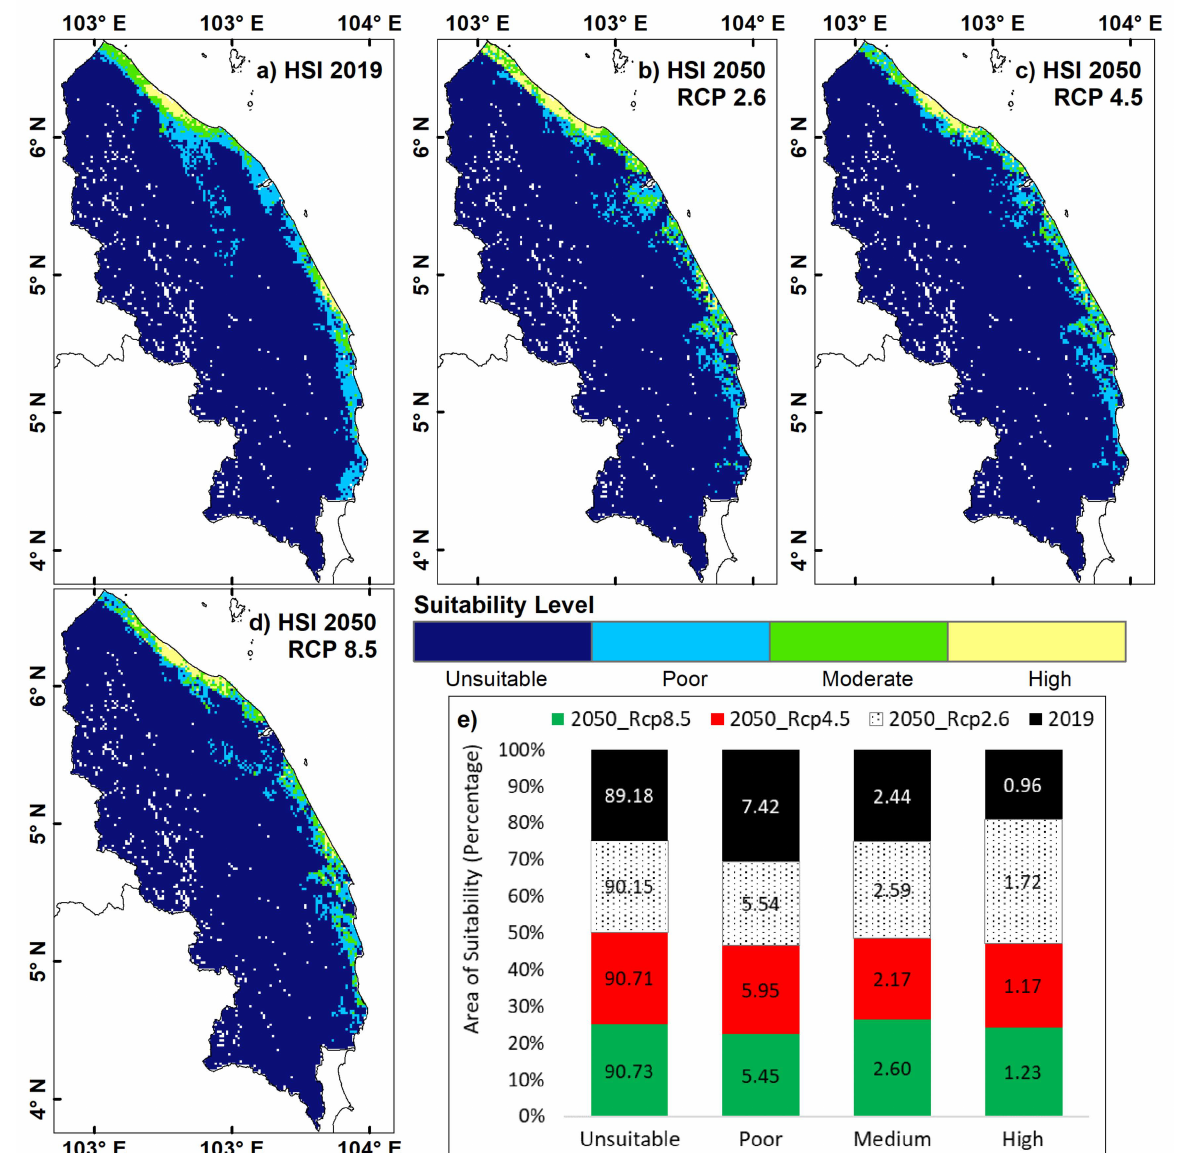
Figure 6. Prediction of potentially suitable habitat for M. cajuputi species in Terengganu, Malaysia. The suitability index was classified into high (0.75–1.0), medium (0.5–0.75), poor (0.25–0.5) and unsuitable (0–0.25) as presented on the map. The map compared the habitat suitability under the current climate ( a ) with a future projection in 2050 using the ensemble GCMs at RCPs of 2.6 ( b ), 4.5 ( c ) and 8.5 ( d ). Area percentage of habitat suitability under the current climate and future 2050 are shown in the stacked bar where colors represent the climate condition ( e